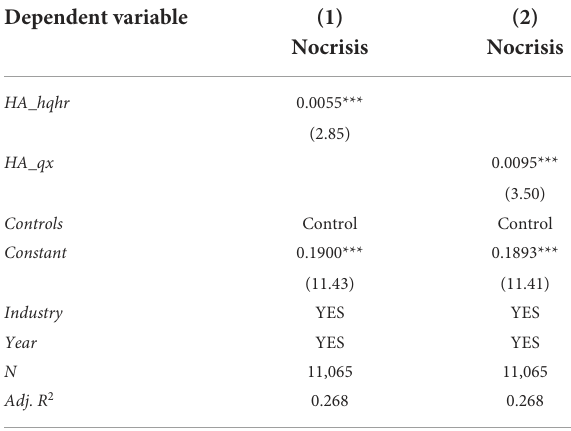
TABLE 11 Excluding the impact of the financial